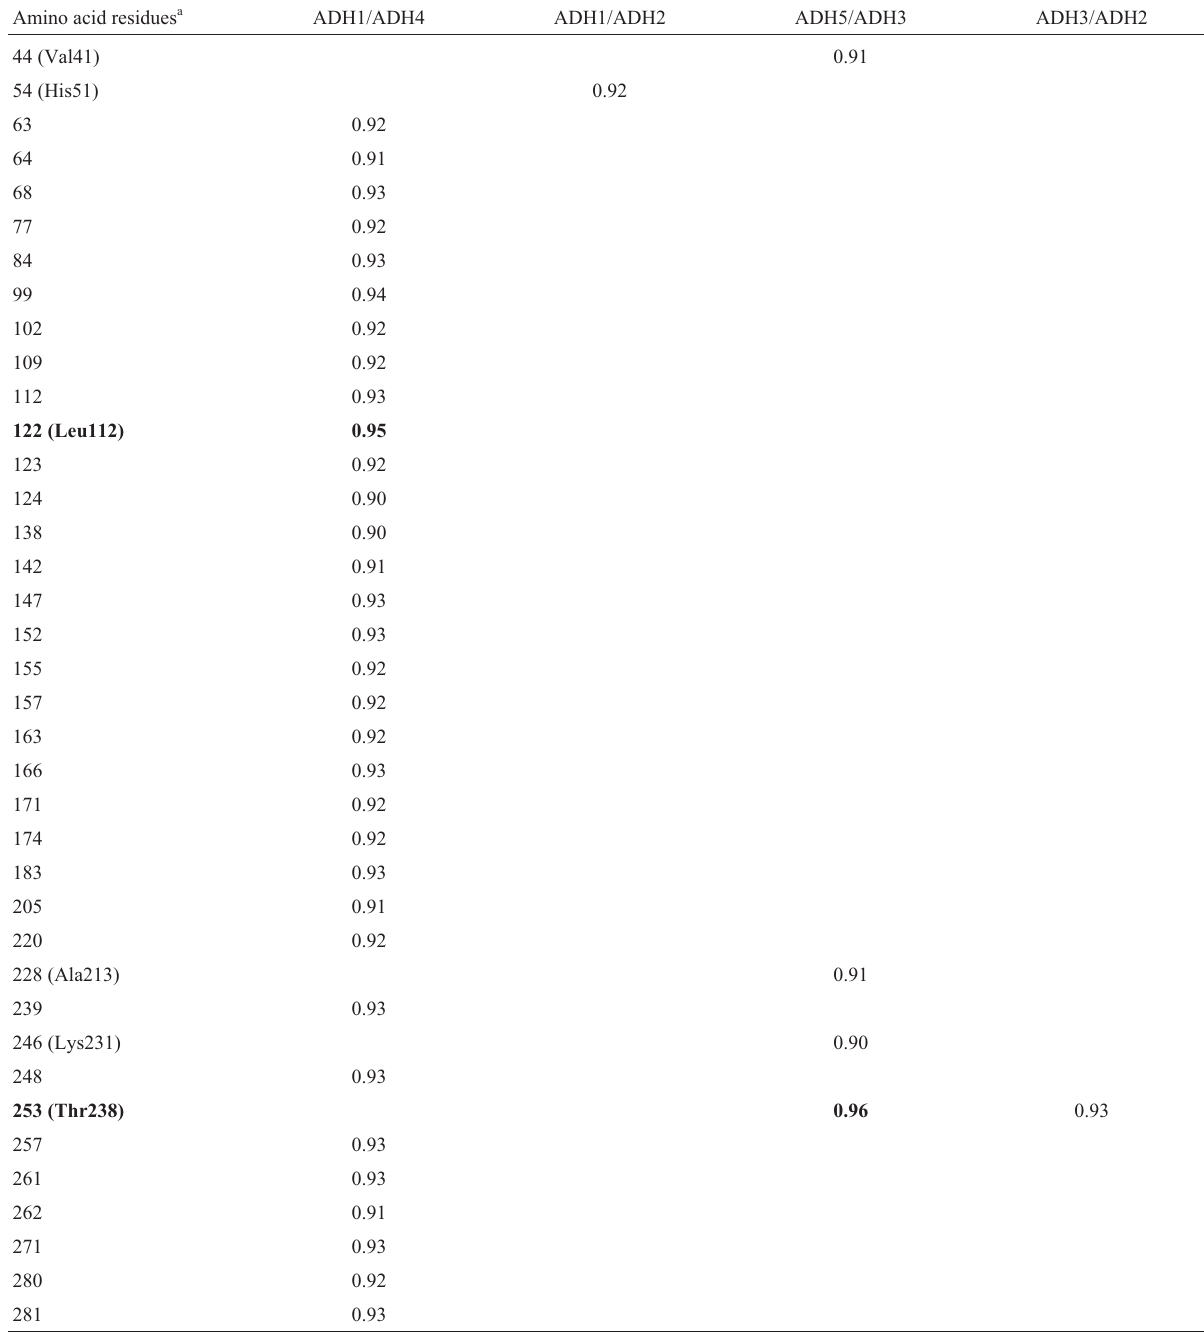
Table 3 - Amino acid residues important for the functional divergence between mammalian ADH